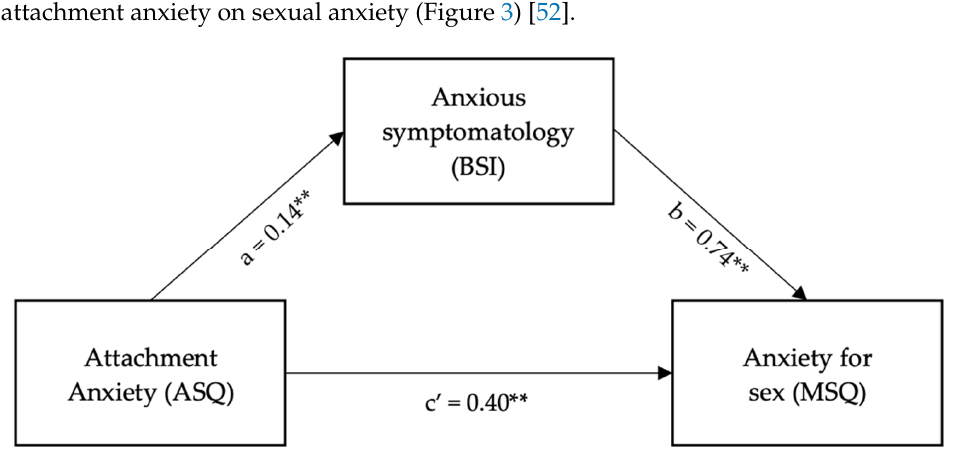
Figure 3. Results of Hypothesis 2 mediation model. ** p < 0.001.